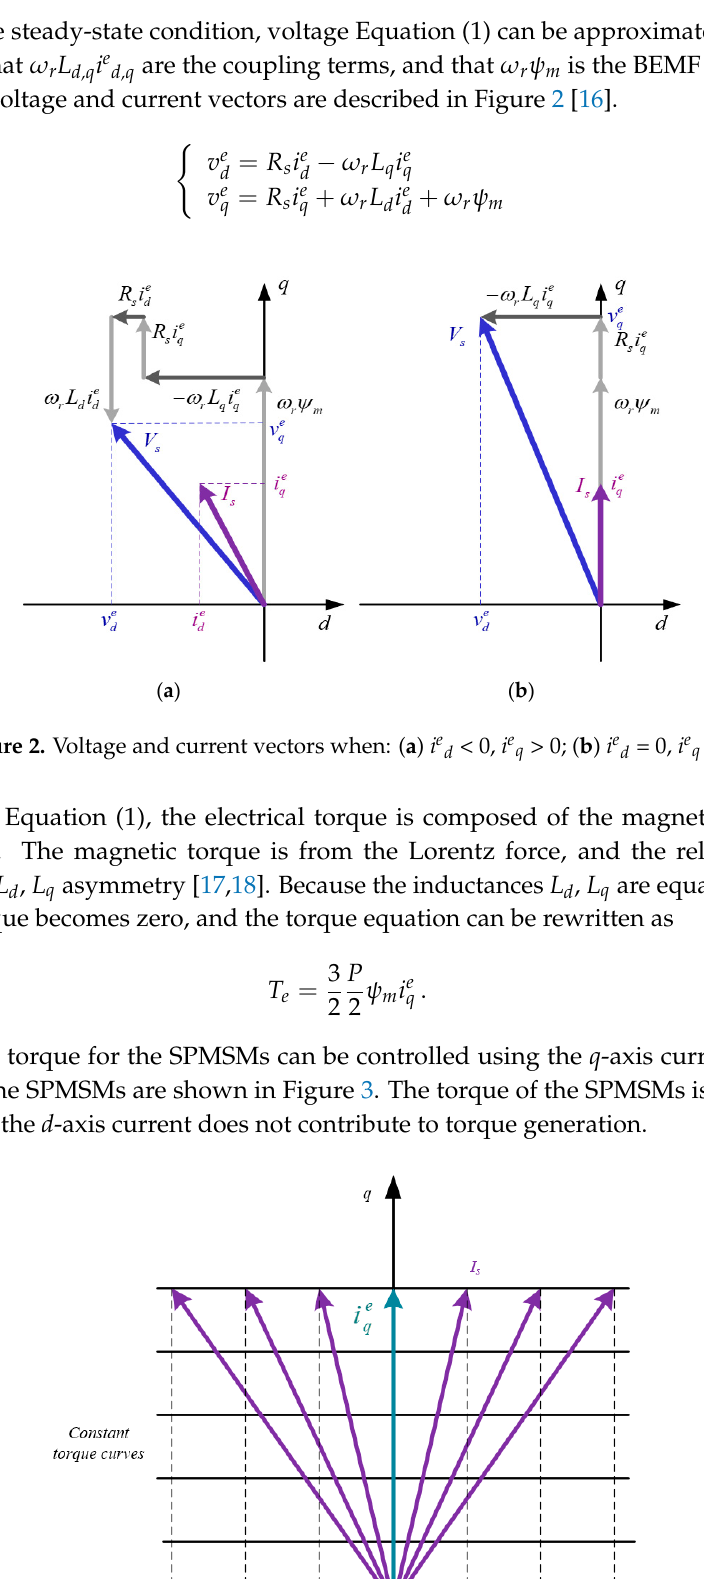
Figure 3. Constant torque curves for surface-mounted permanent magnet synchronous motors